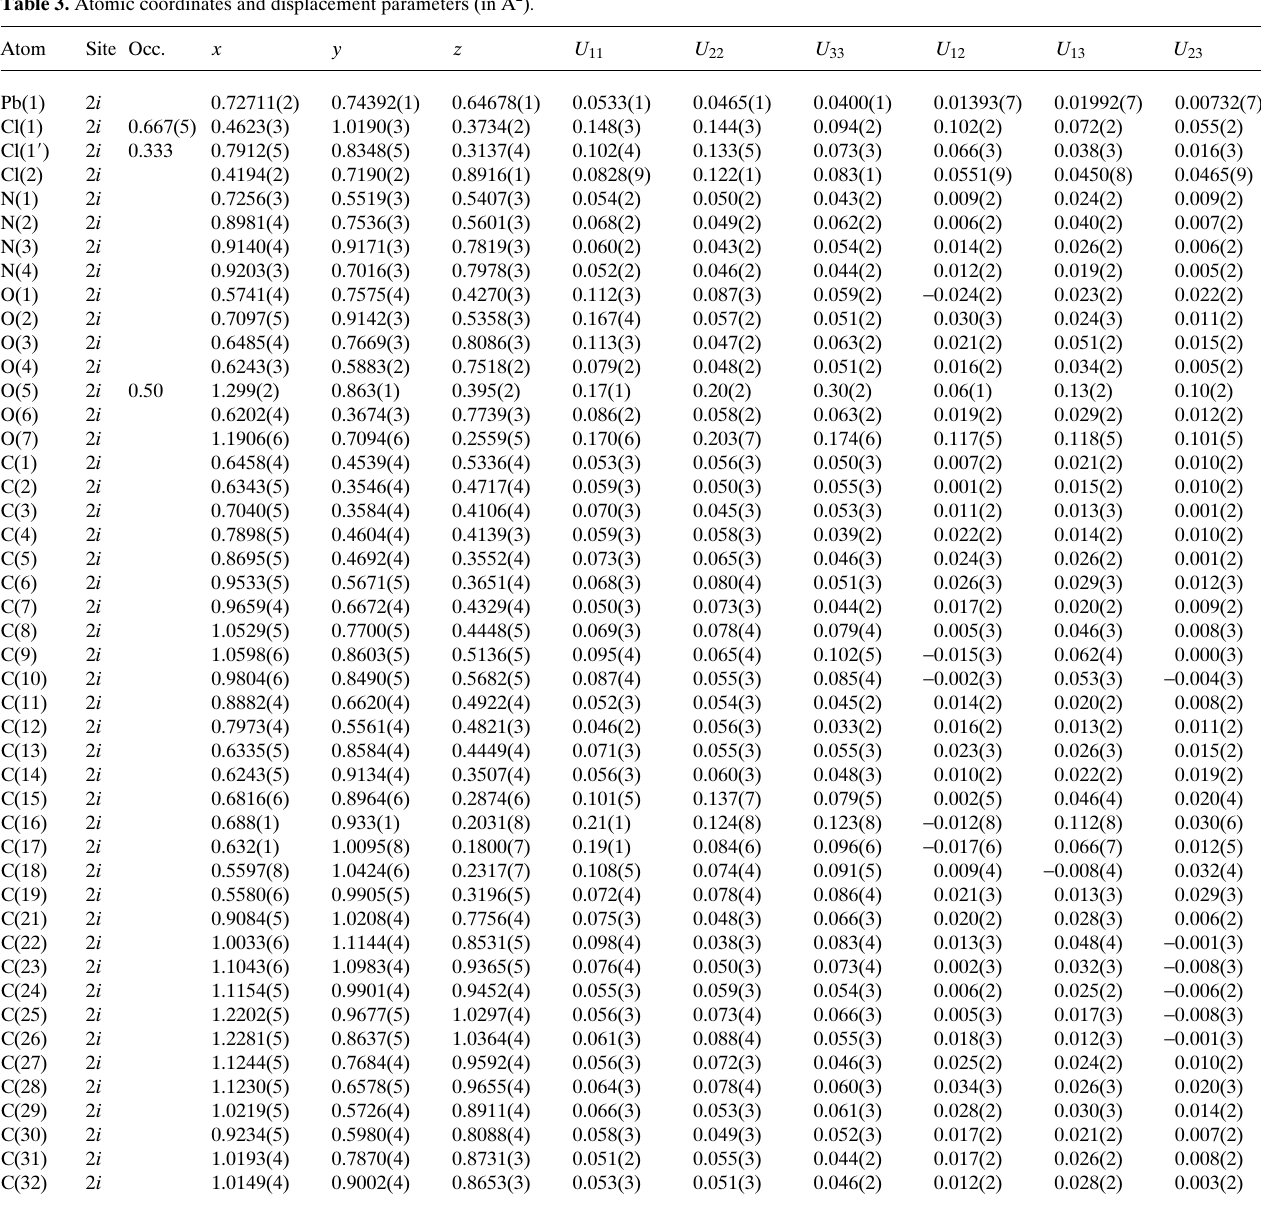
Table 3. Atomic coordinates and displacement parameters (in Å 2 ) .